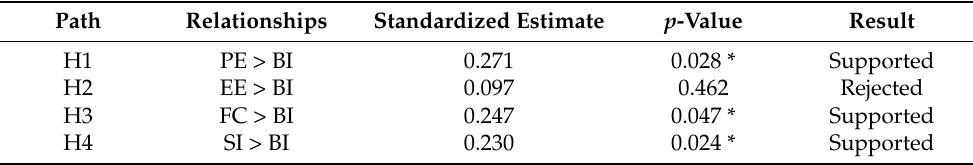
Table 9. Test results from the structural